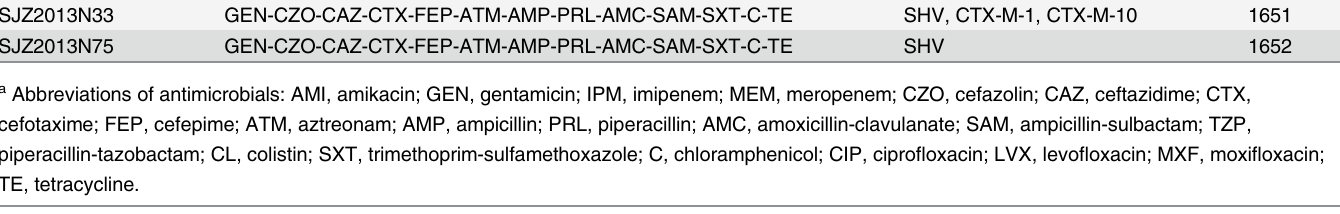
Table 3. Characteristics of the 2 ESBL-Producing K . pneumoniae Isolates Detected in this Study. Strain ID Antimicrobial resistance patterns a